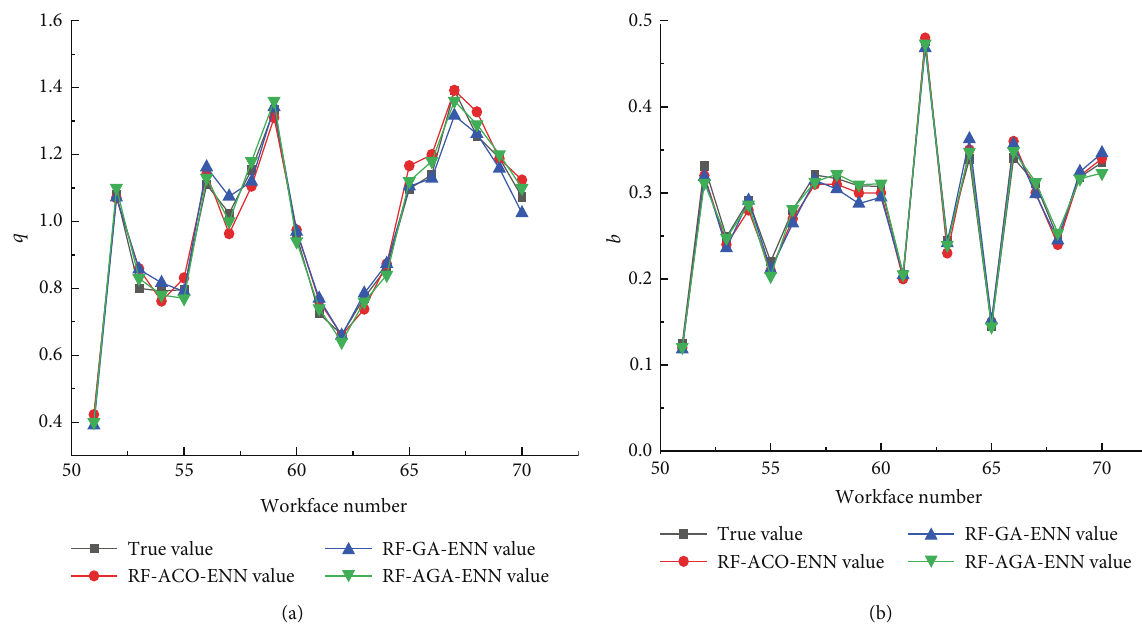
Figure 12: PIM parameter prediction results under di ff erent input layer conditions.